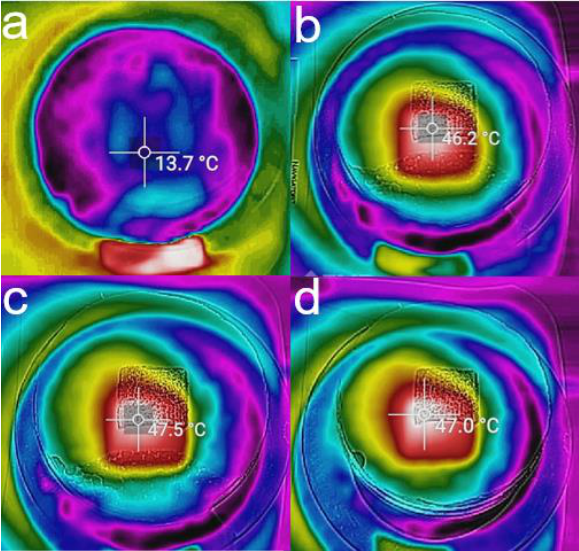
Figure 4. IR image of the carbonized coconut fiber membrane (375 °C, 4 min) under 3 suns: ( a ) initial, ( b ) 5 min, ( c ) 1 h, and ( d ) 2 h.